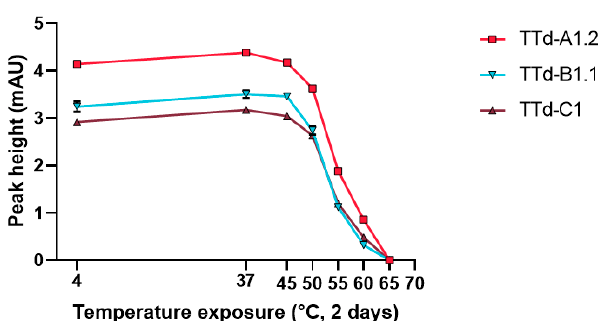
Figure 7. Monomer quantification of temperature exposed tetanus toxoids by size exclusion Figure7. Monomerquantificationoftemperatureexposedtetanustoxoidsbysizeexclusionchromatography. chromatography. Error bars represent the SD of three aliquots of the same batch. Error bars represent the SD of three aliquots of the same